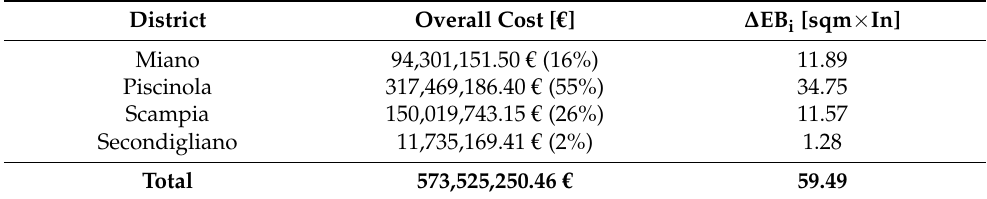
Table 9. Total intervention costs in euro and the rise of the ecological benefit index.